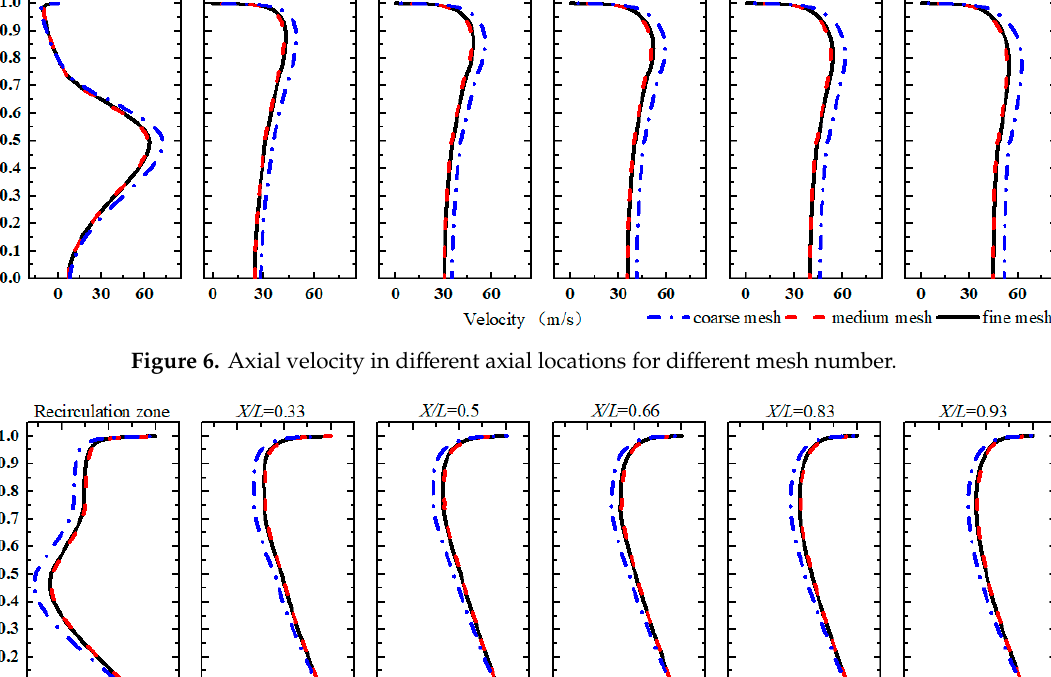
Figure 6. Axial velocity in different axial locations for different mesh number.